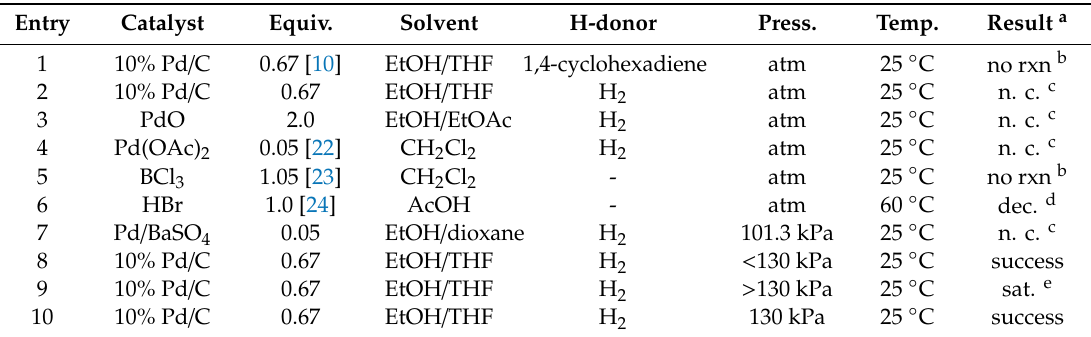
Table 1. Applied methods of conversion of 7 to 8 .